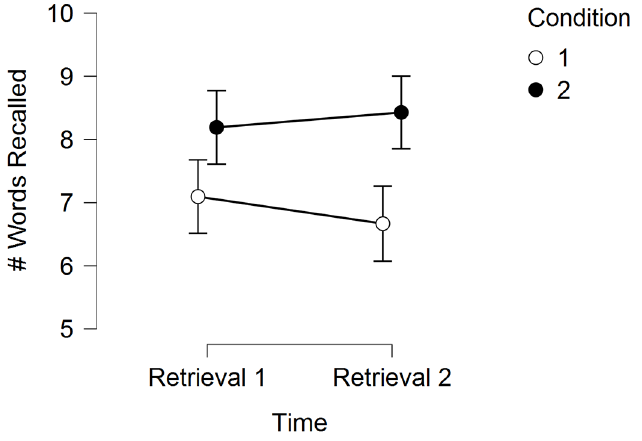
Experiment 2 memory performance (mean words recalled) across time for the two experimental conditions